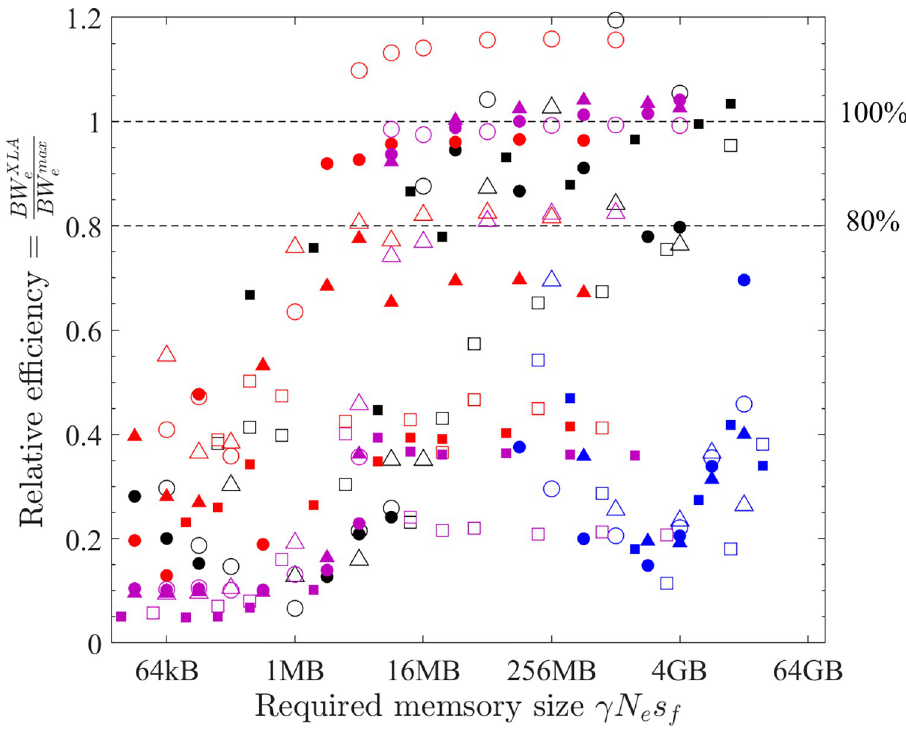
Fig 21. Relative efficiency of XLA for numerical models (hollow = f64; filled = f32; circles = HEAT1D; triangles = HEAT2D; squares = NS2D; black = PC CPU; red = PC GPU; blue = HPC CPU; magenta = HPC GPU).